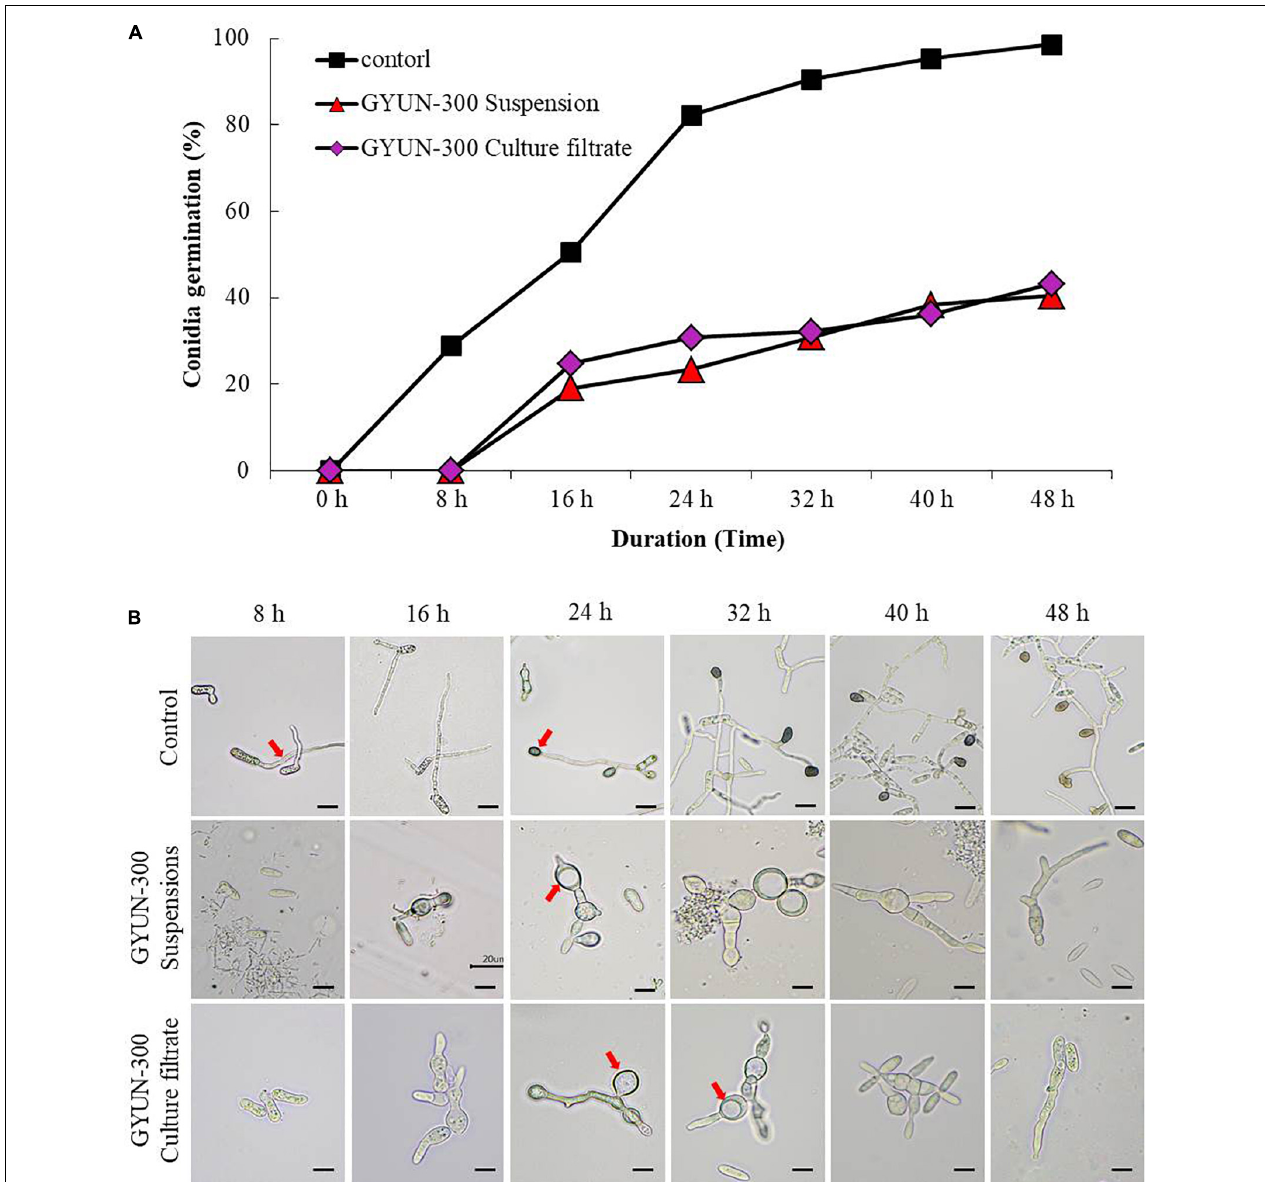
FIGURE 3 | Effect of bacterial cell suspensions and culture filtrate (CF) of Bacillus tequilensis GYUN-300 treatment on conidia germination rate (%) of Colletotrichum acutatum and microscopic observation: (A) Conidial germination rate (%) was suppressed by CF and bacterial cell suspensions, while the germination rate (%) was increased in the non-treated control; and (B) microscopic observations of C. acutatum fungal spore germination after GYUN-300 treatment during the incubation period from 8 to 48 h. The germination counting was carried out using a hemocytometer. Bar = 10 µ m. The experiment was repeated at least once, with treatments repeated in triplicate producing similar